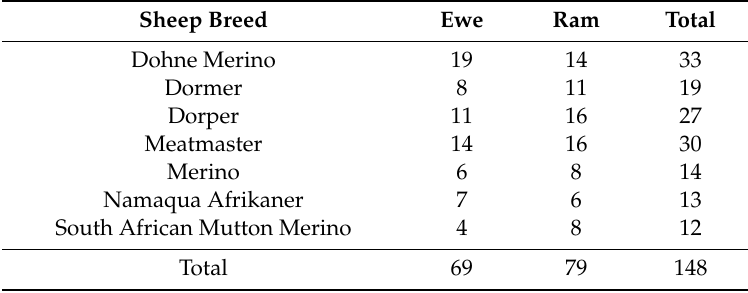
Table 1. Numbers of ewe and ram lamb carcasses assessed for the South African sheep breeds slaughtered at an ideal slaughter weight to produce premium lamb carcass.